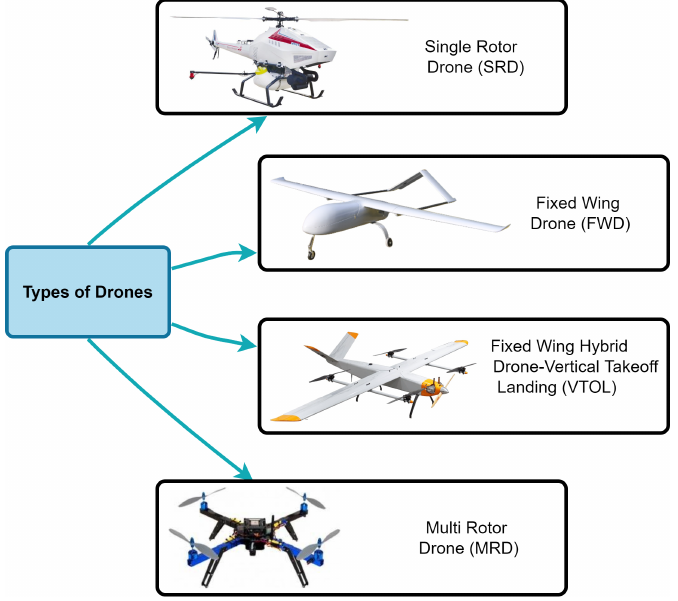
Figure 1. Types of